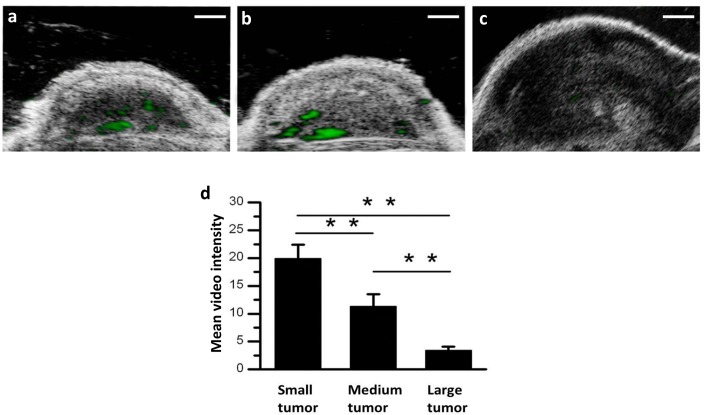
Transverse color-coded ultrasonography after intravenous administration of RGD-MBs obtained at three different tumor stages of subcutaneous Hep-2 tumor xenografts.(a) Small tumor (50–150 mm3). (b) Medium tumor (151–250 mm3). (c) Large tumor (> 250 mm3). Green represents targeted ultrasound signals from adherent RGD-MBs. (d) Quantitative analysis revealed ultrasound imaging signal intensity was highest in the small tumor group (** P < 0.01).